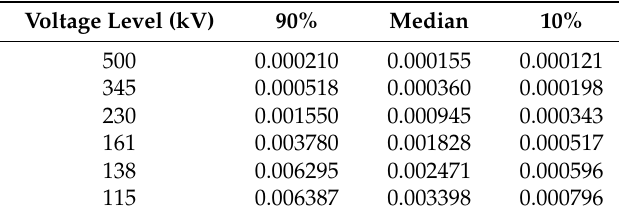
Table 3. Transmission line per-km, per-unit X, for EI.